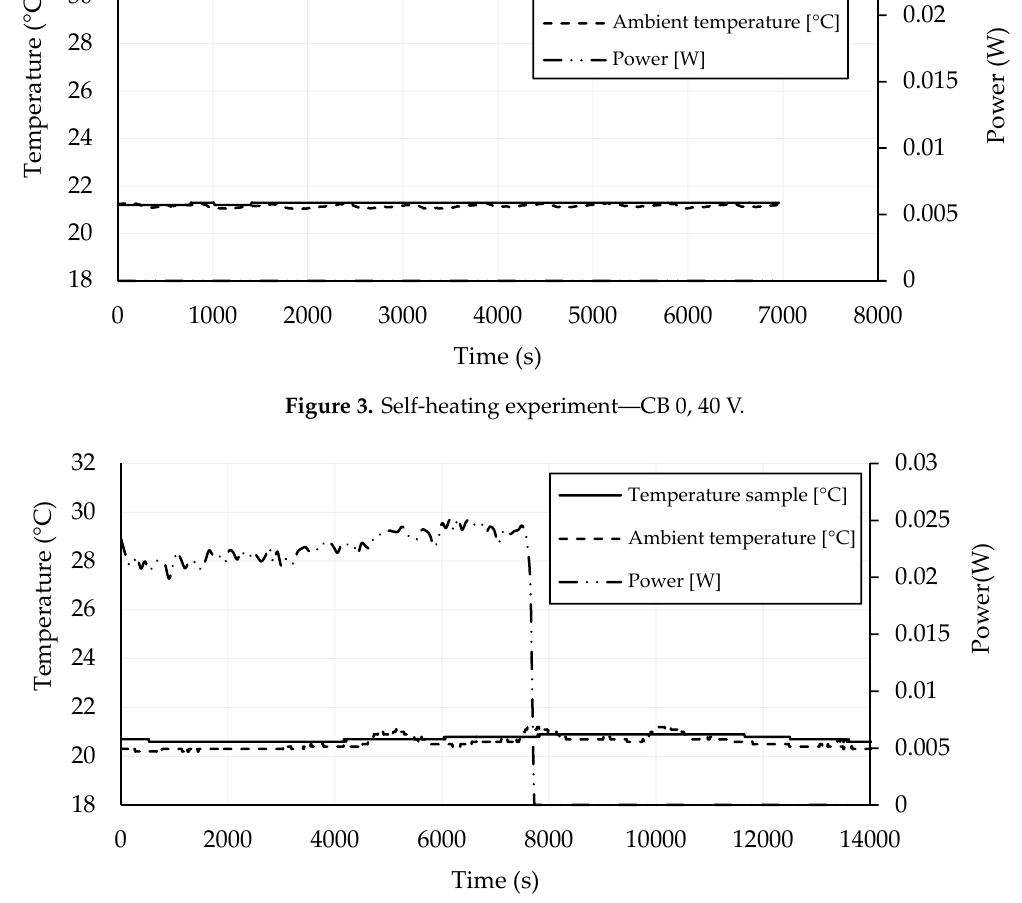
Figure 4. Self-heating experiment—CB 0.75, 40 V.